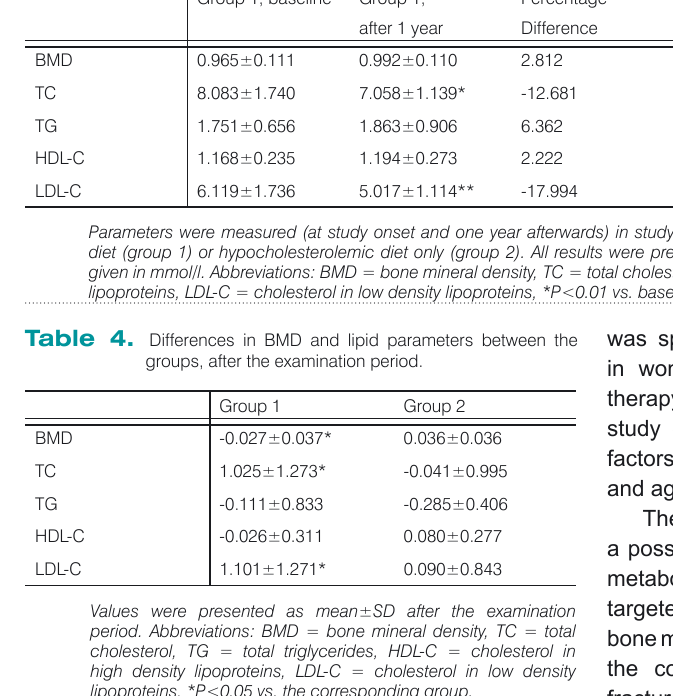
Values were presented as mean±SD after the examination period. Abbreviations: BMD = bone mineral density, TC = total cholesterol, TG = total triglycerides, HDL-C = cholesterol in high density lipoproteins, LDL-C = cholesterol in low density lipoproteins, *P<0.05 vs. the corresponding